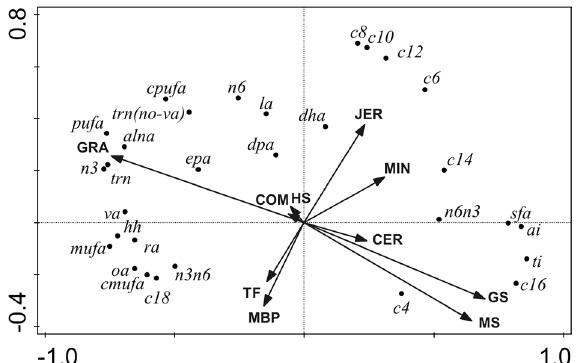
Figure 2. Biplot derived from the redundancy analysis, showing the relationship between diet composition parameters (total forage, TF; estimated grazing, GRA; grass silage, GS; maize silage, MS; hay/straw, HS; moist by-products, MBP; cereals, CER; minerals, MIN; compound feed, COM) and breed (Jersey, JER), relative to milk concentrations of butyric acid (c4), caproic acid (c6), caprylic acid (c8), capric acid (c10), lauric acid (c12), myristic acid (c14), palmitic acid (c16), stearic acid (c18), vaccenic acid (va), oleic acid (oa), linoleic acid (la), rumenic acid (ra), α-linolenic acid (alna), eicosapentaenoic acid (epa), docosapentaenoic acid (dpa), docosahexaenoic acid (dha), saturated fatty acids (sfa), monounsaturated fatty acids (mufa), cis-monounsaturated fatty acids (cmufa), polyunsaturated fatty acids (pufa), cis-polyunsaturated fatty acids (cpufa), omega-3 fatty acids (n3), omega-6 fatty acids (n6), omega-3:omega-6 (n3n6), omega-6:omega-3 (n6n3), trans fatty acids (trn), trans fatty acids excluding vaccenic acid (trn(no-va)), atherogenicity index (ai), thrombogenicity index (ti) and hypocolesterolemic to hypercolesterolemic ratio (hh). The total adjusted explained variation was 57.7%. Axis 1 explained 54.2% of the variation and Axis 2 explained a further 3.3% of the variation. Continuous variables, shown as arrows were the following (presented in order of contribution to the explained variation; P -value also shown in parentheses): GRA (30.3%, P = 0.002), COM (10.0%, P = 0.002),